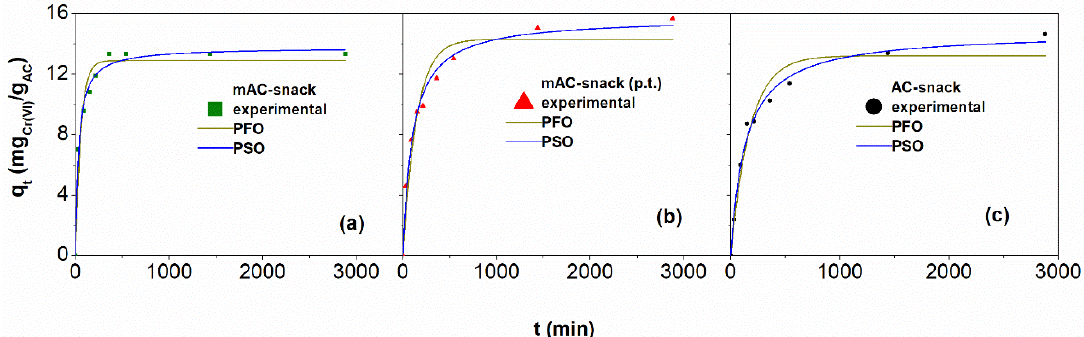
Figure 2. Pseudo First Order (PFO) and Pseudo Second Order (PFO) kinetic models fitted upon the ( a ) mAC-snack, ( b ) mAC-snack (p.t.), and ( c ) AC-snack adsorption experimental data. Results from these fittings are presented in Table 3 and the PSO adsorption kinetic model is obviously the best fitted Table 3. Pseudo First and Pseudo Second Order kinetics comparison. Adsorption rate constant, Cr(VI) uptake at equilibrium stage, and initial adsorption rate calculation.